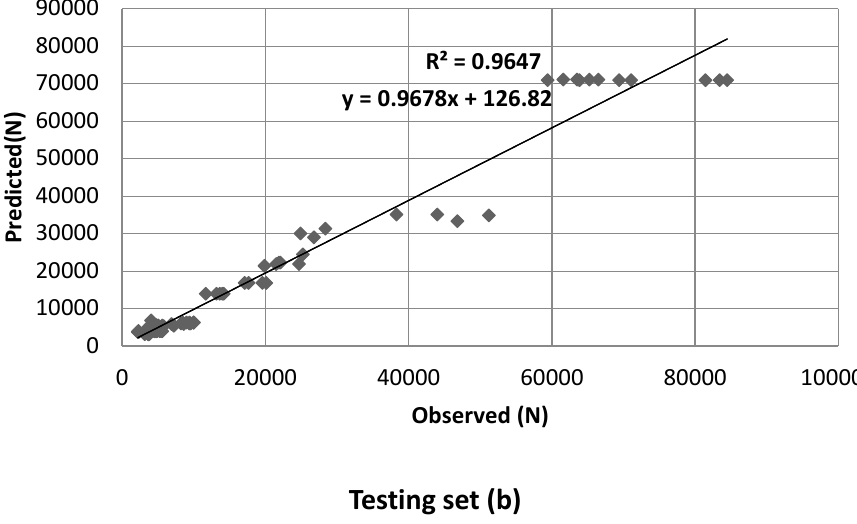
R² = 0.9647 y = 0.9678x + 126.82